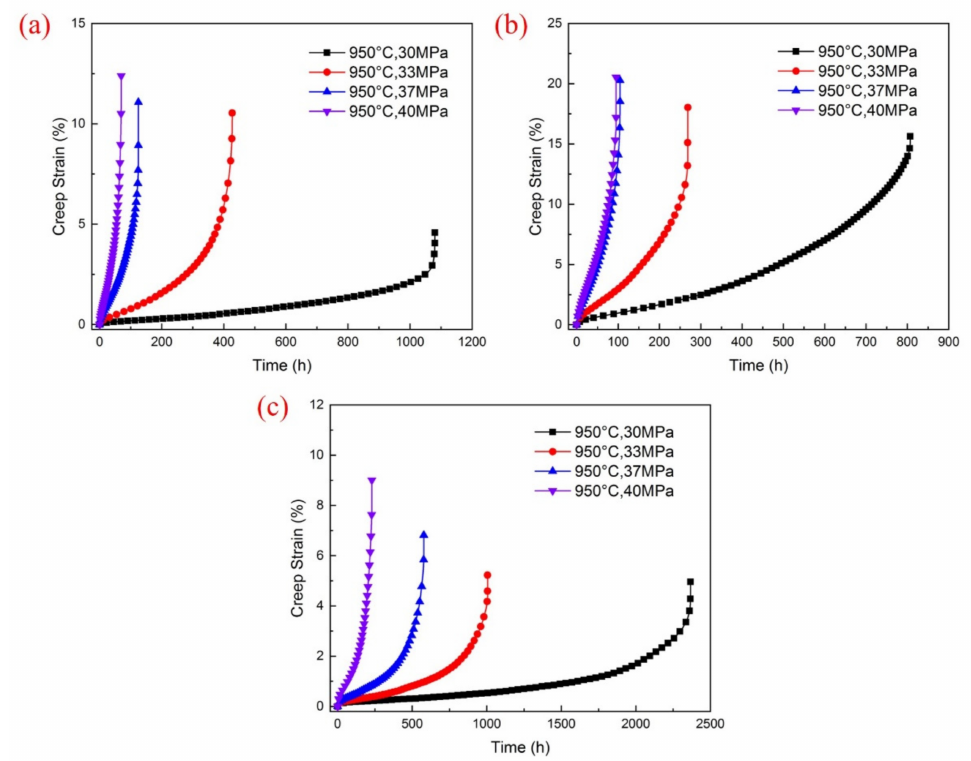
Figure 10. Standard creep time–strain curves of ( a ) as-cast alloy, ( b ) aged alloy, and ( c ) fresh-to-aged welded joint at 950 ◦